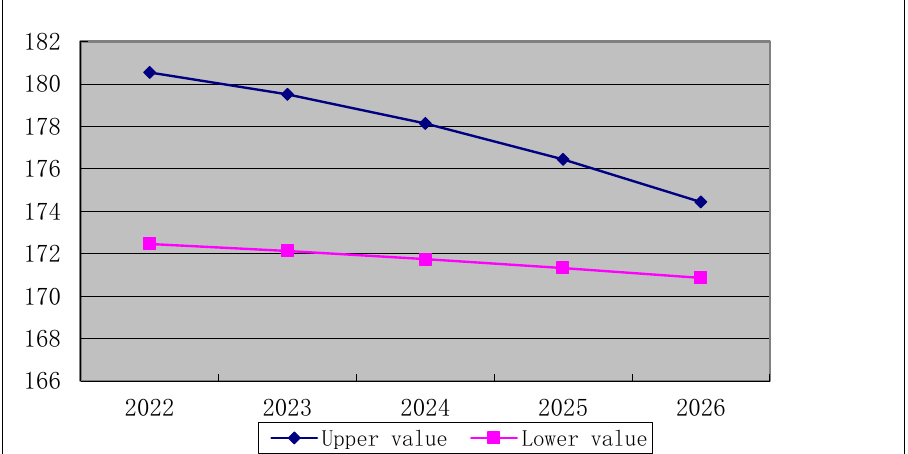
Figure 12. The variation interval of water requirement with the influence of the tertiary industry in Hebei.